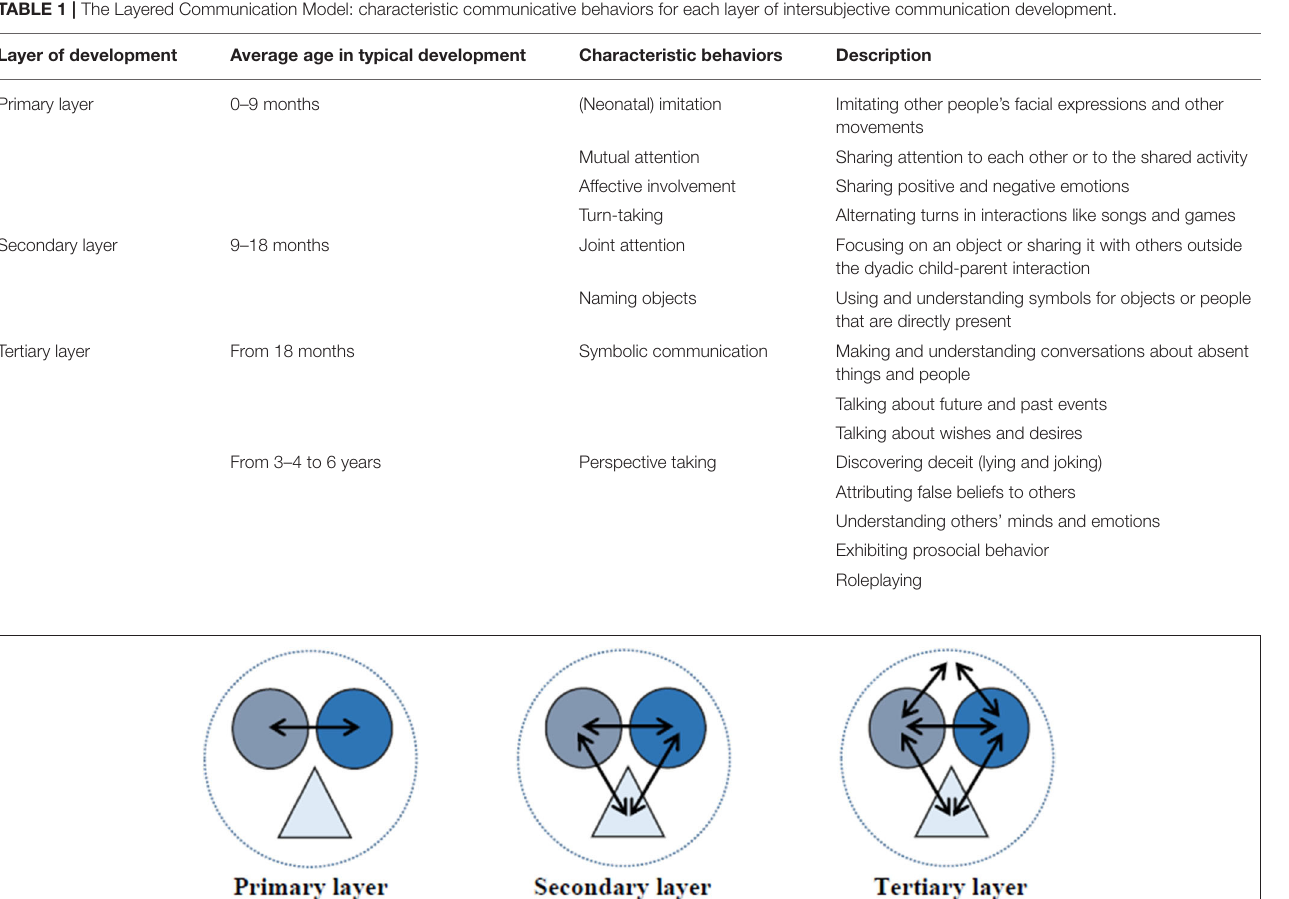
TABLE 1 | The Layered Communication Model: characteristic communicative behaviors for each layer of intersubjective communication development.